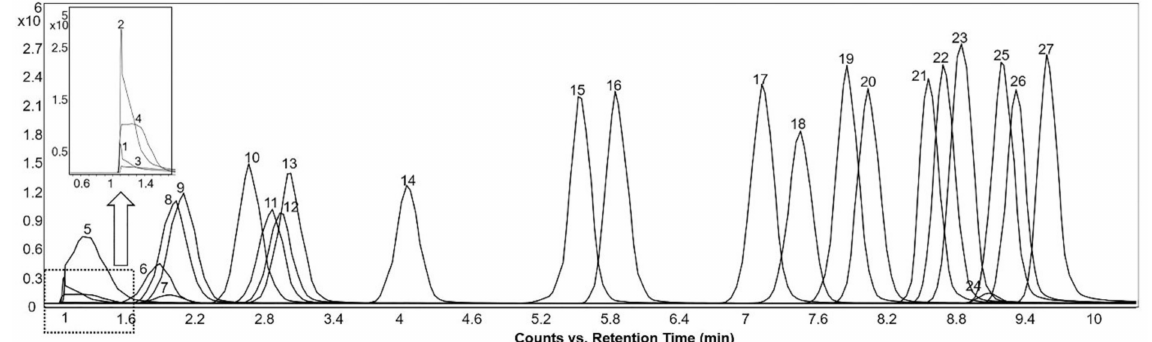
Figure 6. Extracted ion chromatograms of the molecular ions of detected acylcarnitines ac- quired from reference “BACSMLS” standard samples in the positive ionization mode.